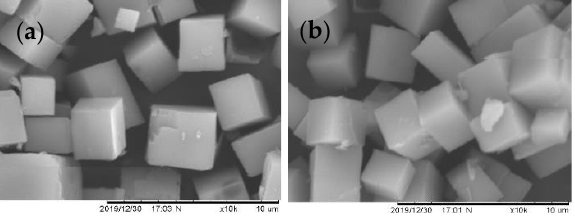
Figure 3. SEM of ( a ) SAPO-34 and ( b ) OTCS-modified SAPO-34.